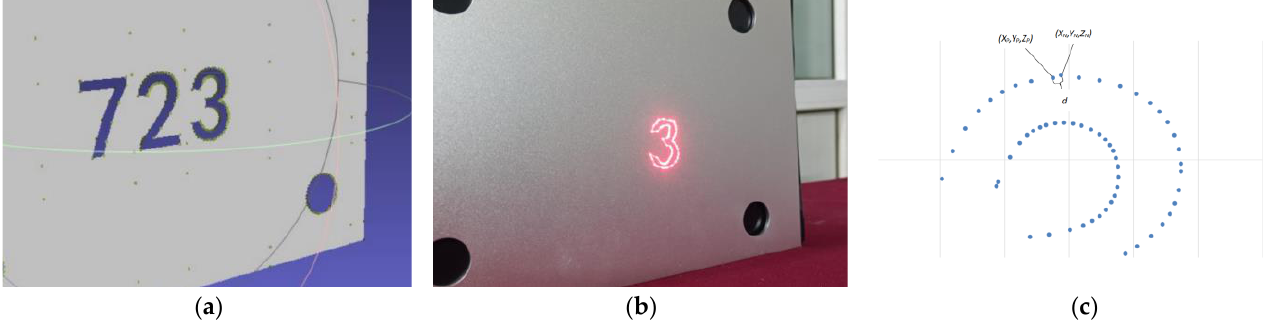
Figure 11. ( a ) The coordinates to be projected on the CAD model, in the shape of the number “723”, ( b ) actual projected coordinates, like the number “3” and ( c ) System Error Diagram.